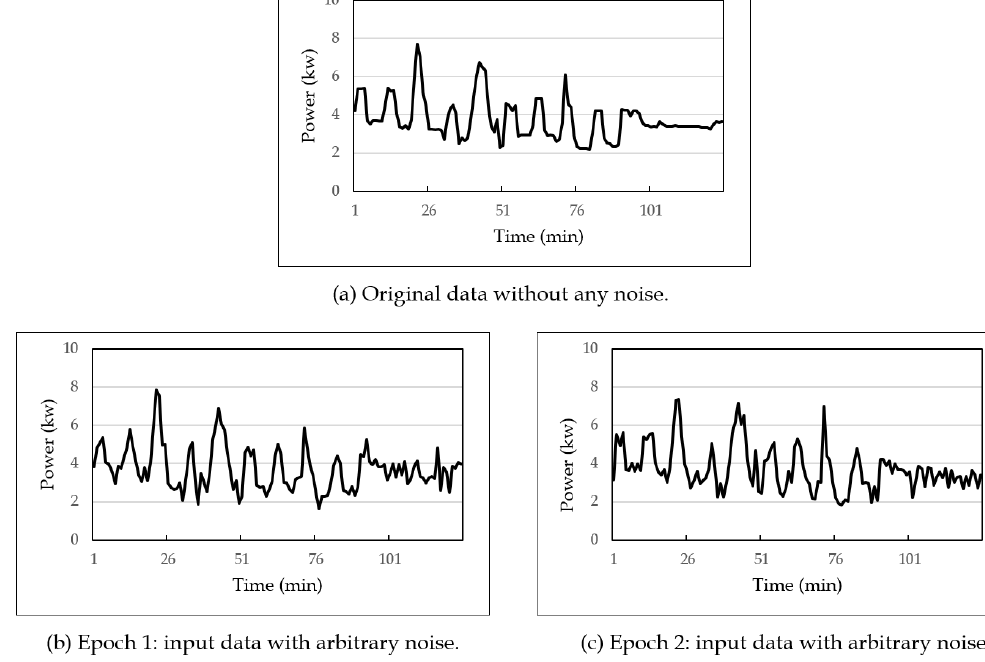
Figure 7. An example of training data used for each learning